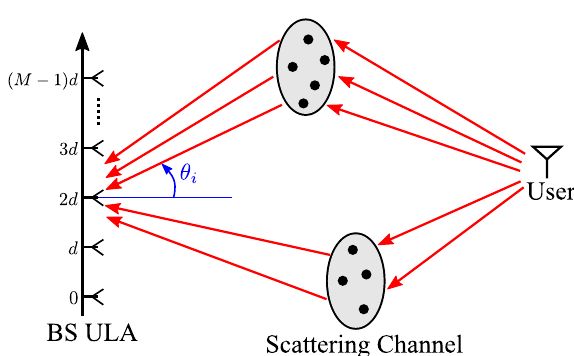
Fig. 1 A cartoonish representation of a multipath propagation channel, where the user signal is received at the BS through two scattering